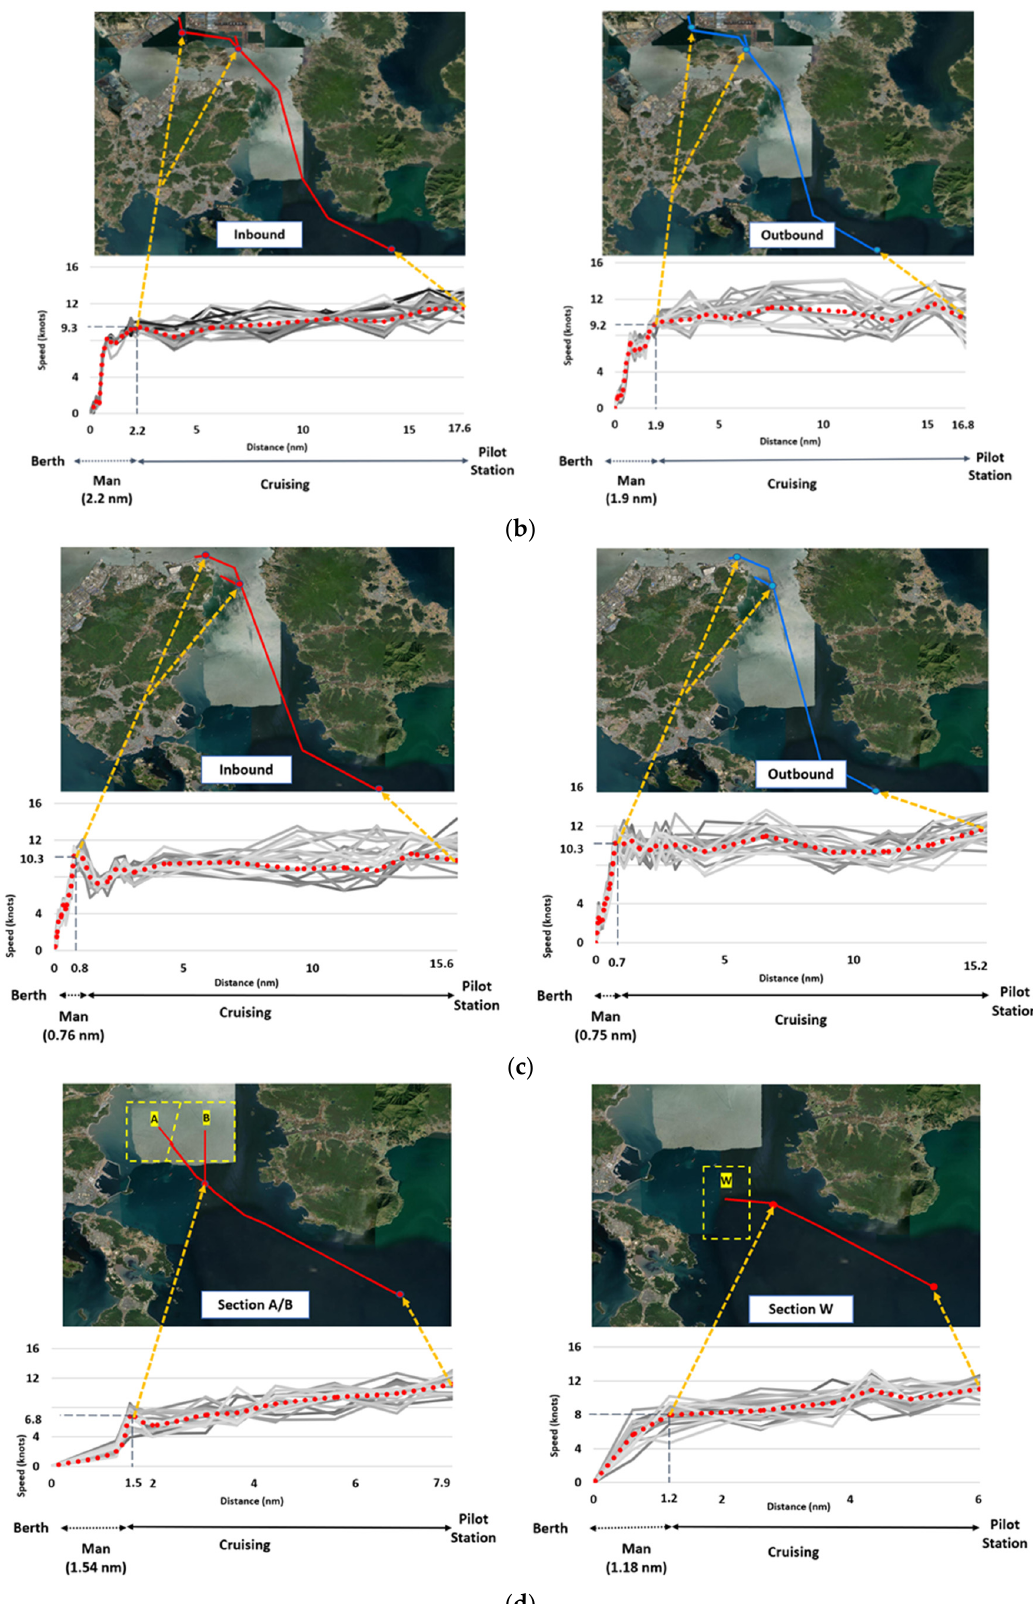
Figure 3. Ship route and speed change inside the port area. ( a ) Container ship. ( b ) Bulk and general cargo ship. ( c ) Tanker ship. ( d ) Anchorage area.